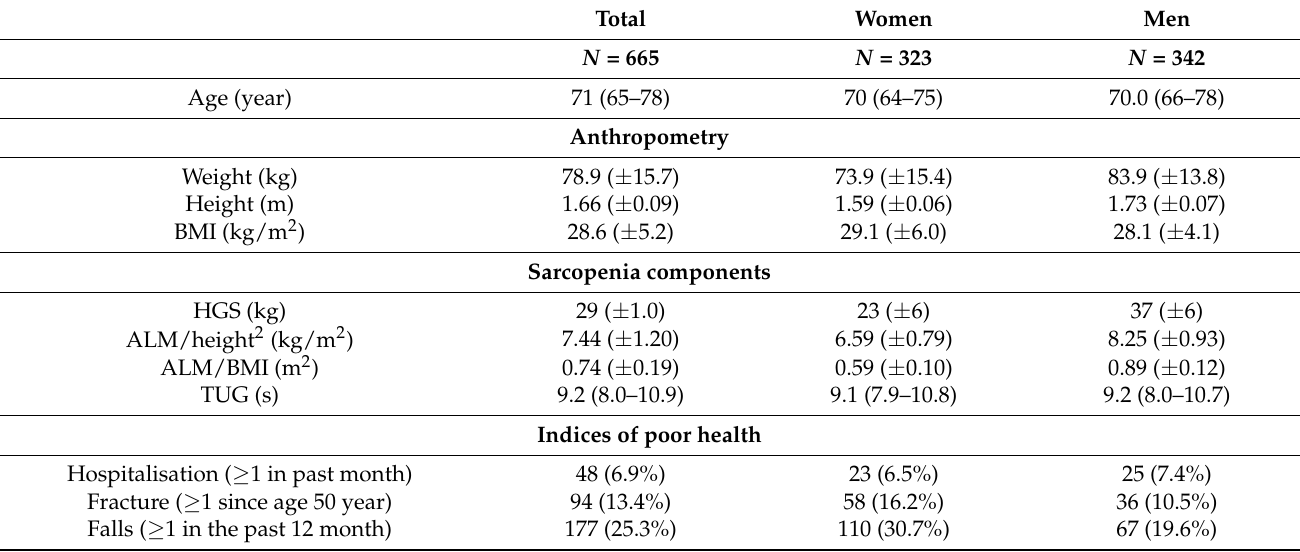
Table 1. Participant characteristics. Data are expressed as mean ( ± SD) or median (IQR) or n (%). Total Women Men N = 665 N = 323 N =